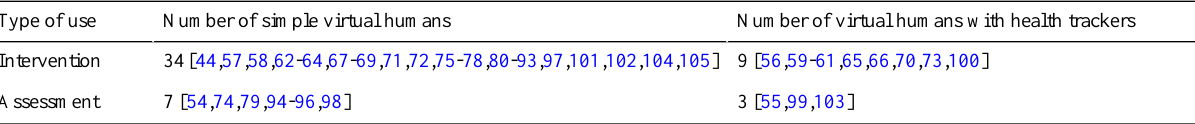
Number of virtual humans with health trackersNumber of simple virtual humansType of